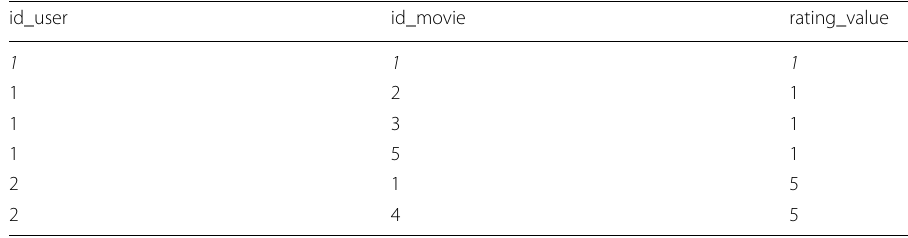
Table 2 Examples of rating data